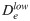
Plot of the Morse potential’s well depth De.Following Eq (10), De is calibrated as a function of λ2, the second invariant of the flow strain rate tensor, where Delow defines the lower bound of the platelet’s adhesive force.